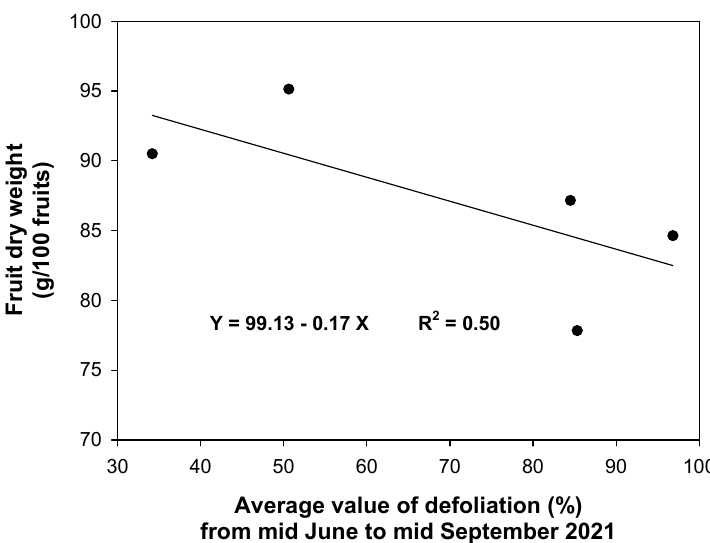
Figure 8. Relationship between the fruit dry weight in 2021 and the average defoliation of old leaves from mid-June to mid-September.